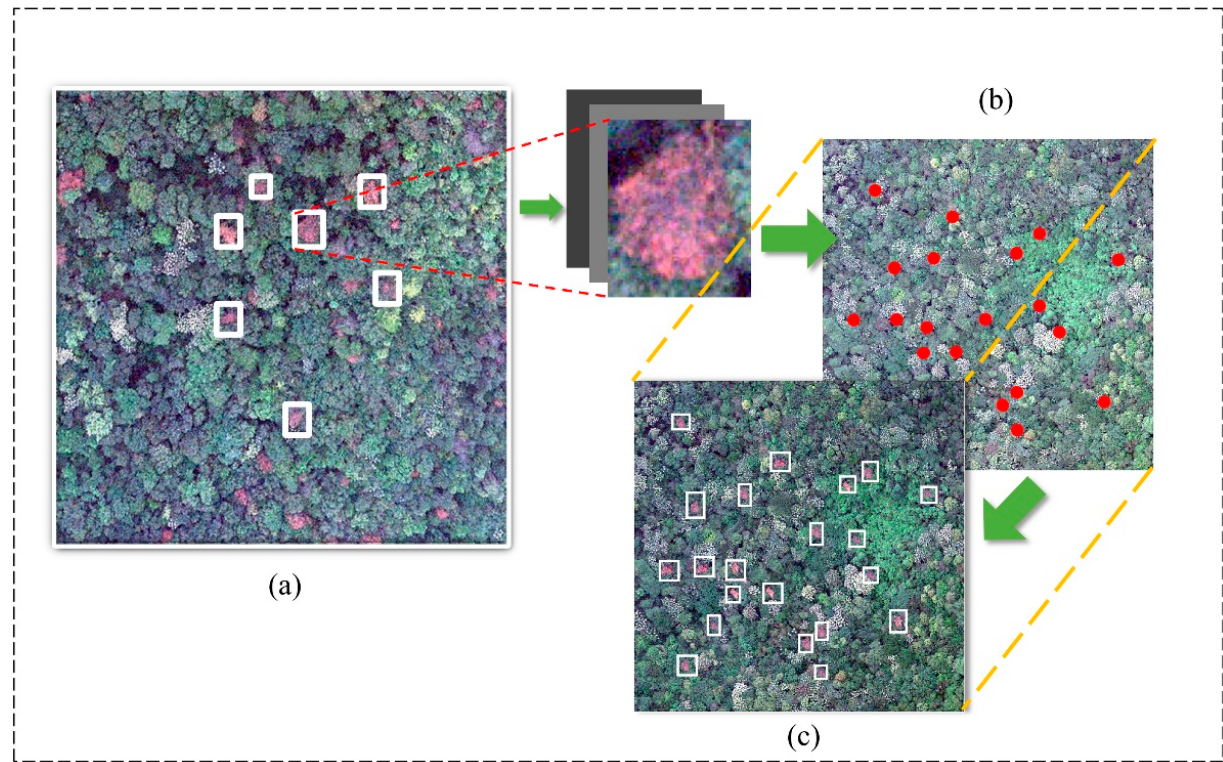
Figure 3. Schematic diagram of the data enhancement process. ( a ) Crop out the SDTs with adapted pixel size window from each image without overlap; ( b ) pasted at random without overlap; ( c ) locations in the pasted area in non-diseased pine area.